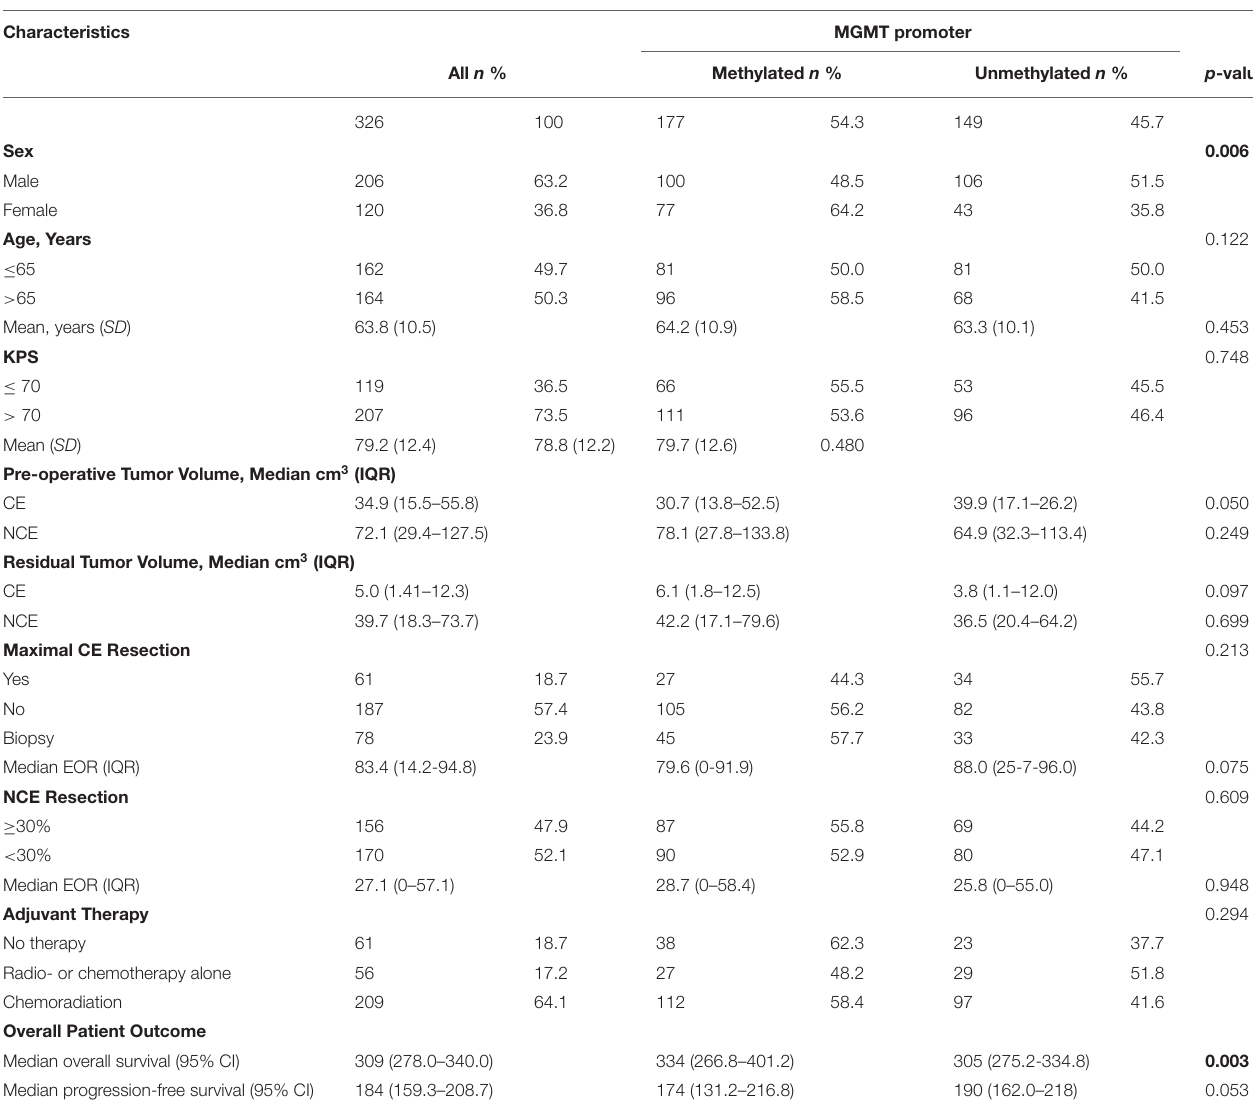
TABLE 1 | Patient and tumor